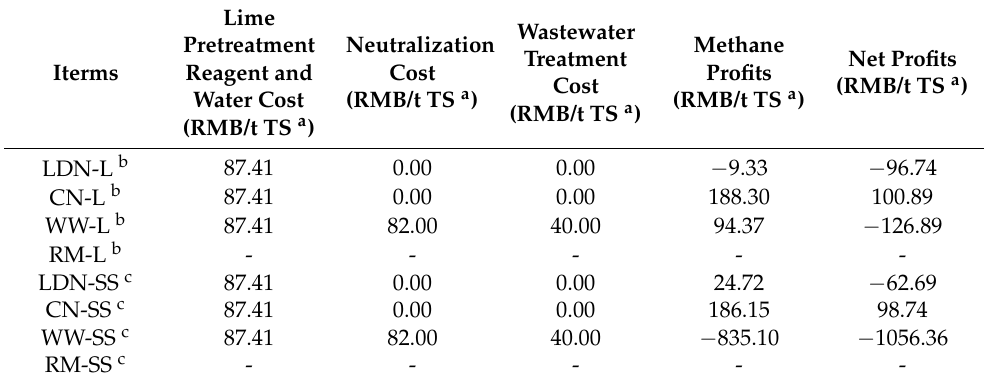
Table 3. Economic evaluation of different neutralization methods for lime-pretreated corn stover.